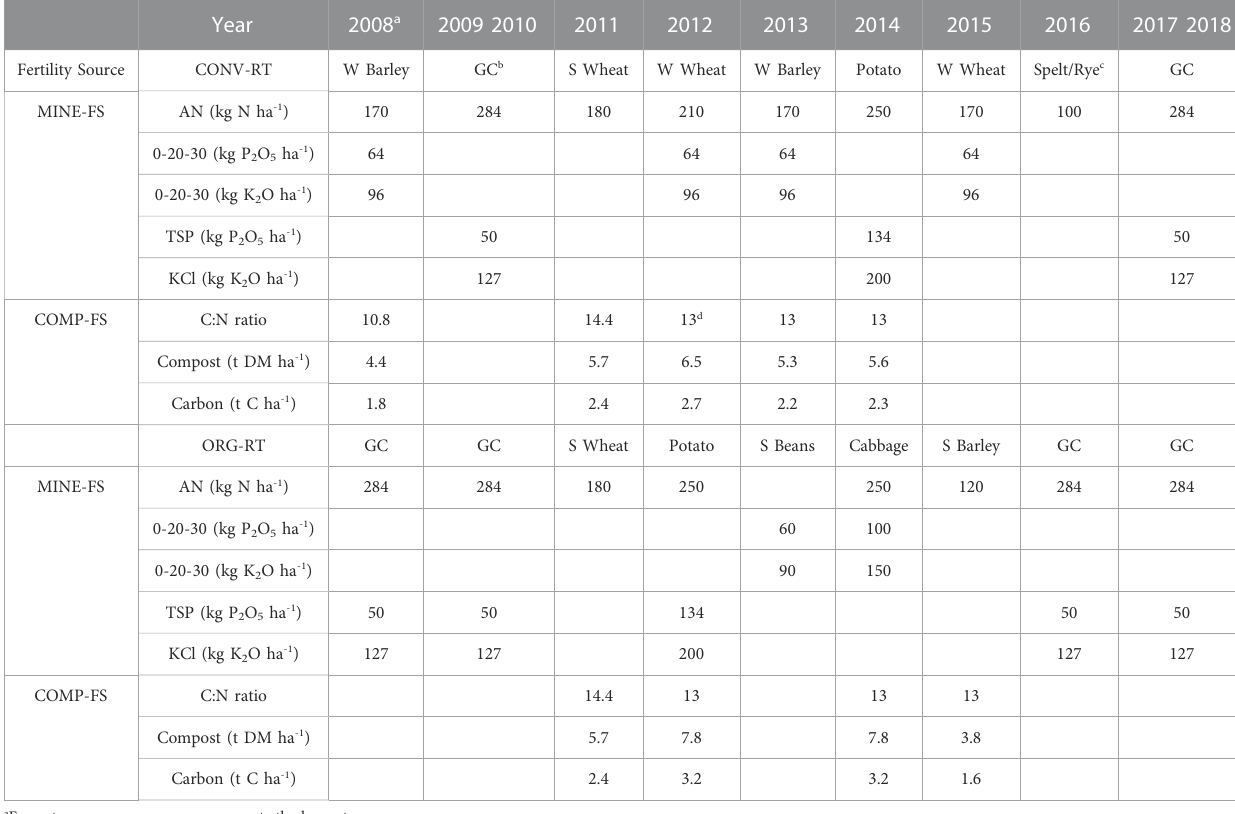
TABLE 1 Crop sequence, fertility inputs, and management details for conventional and organic rotations (conventional-CONV-RT vs. organic-ORG-RT) and fertility sources (mineral-MINE-FS vs. compost-COMP-FS) in the NFSC trial between 2008 and 2018. GC: perennial ryegrass/white clover ley; W = winter; S = spring; AN = ammonium nitrate; TSP = triple super phosphate; KCL = muriate of potash; 0-20-30 compound fertiliser containing 20% P 2 O 5 and 30% K 2